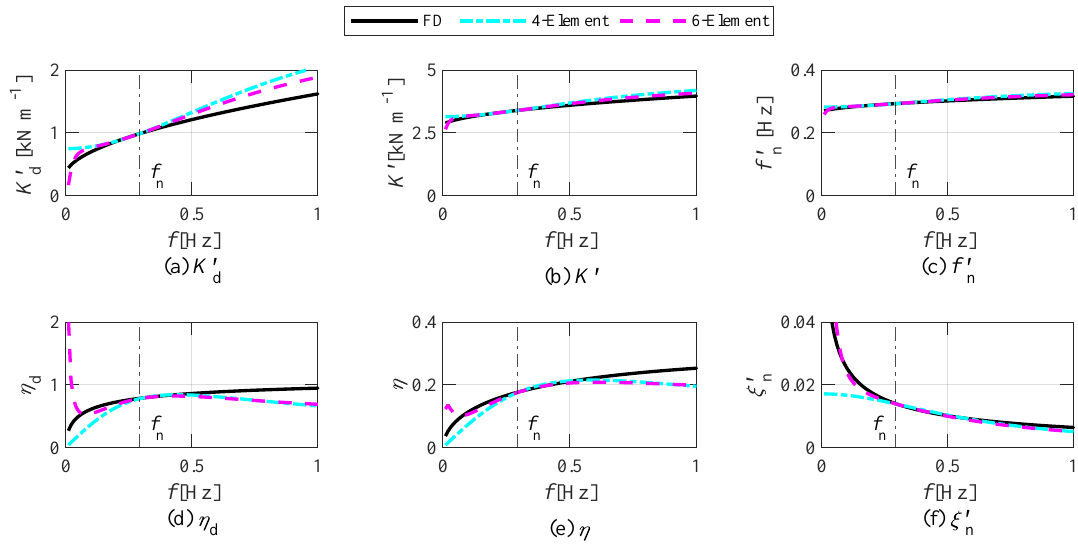
Figure 7. Effect of VE system frequency sensitivity on parameters (2H-SS